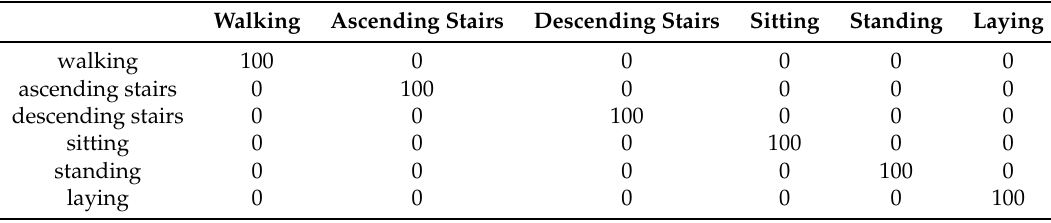
Table 3. Testing confusion matrix of the six single user